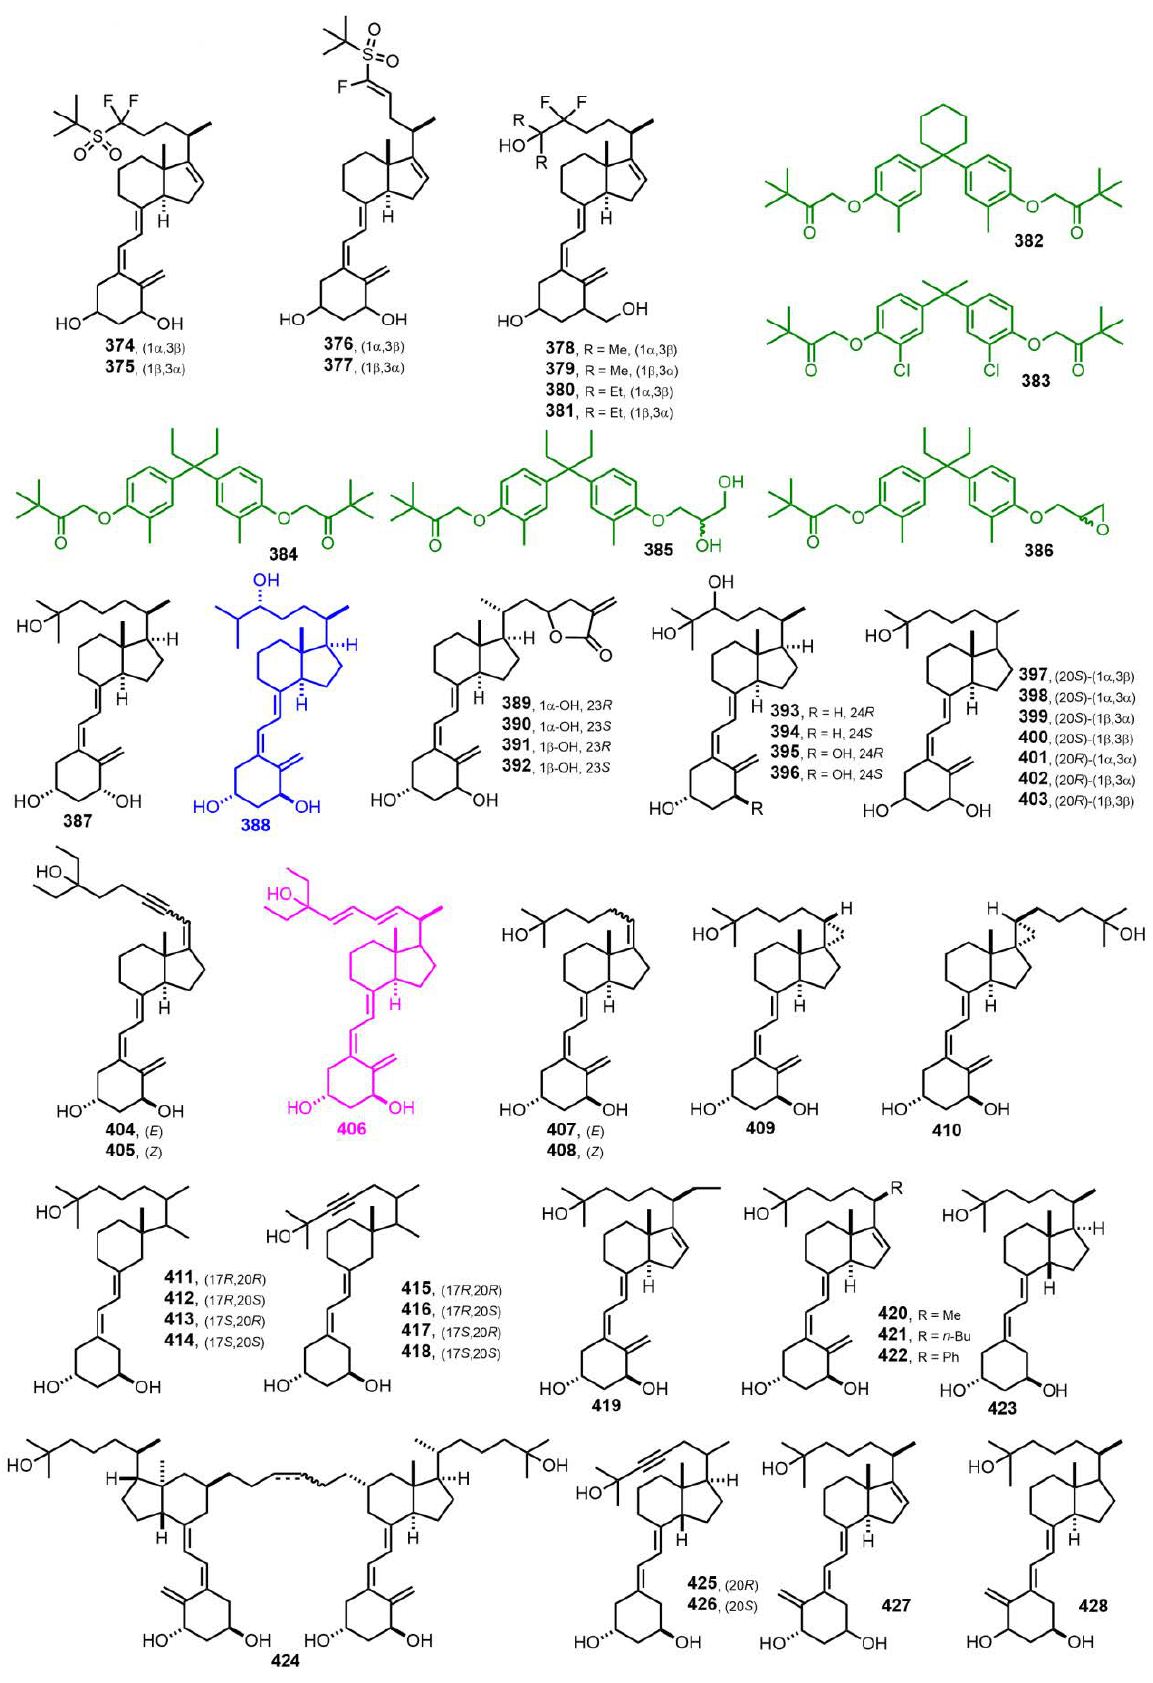
Figure 9. (1999) [158 – 168].